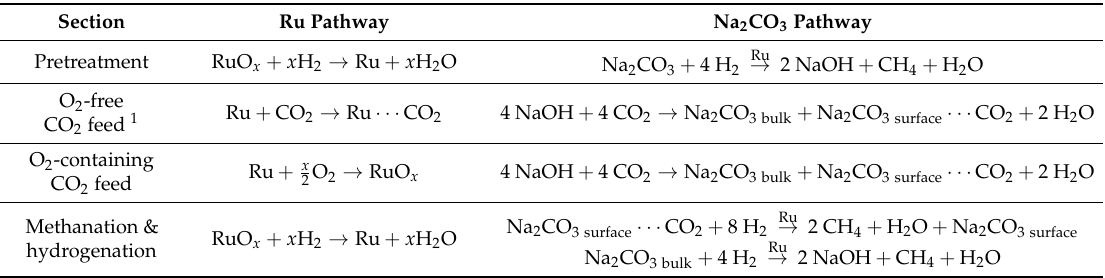
Table 2. Speculated function pathway of Ru and Na 2 CO 3 in the Ru-Na 2 CO 3 DFM.